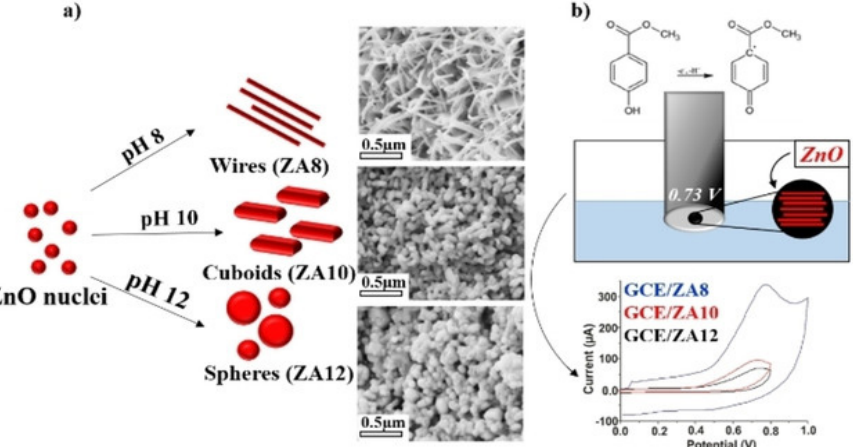
Figure 5. Schematic illustration of the proposed mechanism for ( a ) the growth of ZnO NPs at pH 8, 10, and 12 with their respective SEM images and ( b ) the electrochemical detection of MePa in an aqueous solution using three reported morphologies. Reproduced from reference [122] with permission from John Wiley and Sons, copyright 2021.